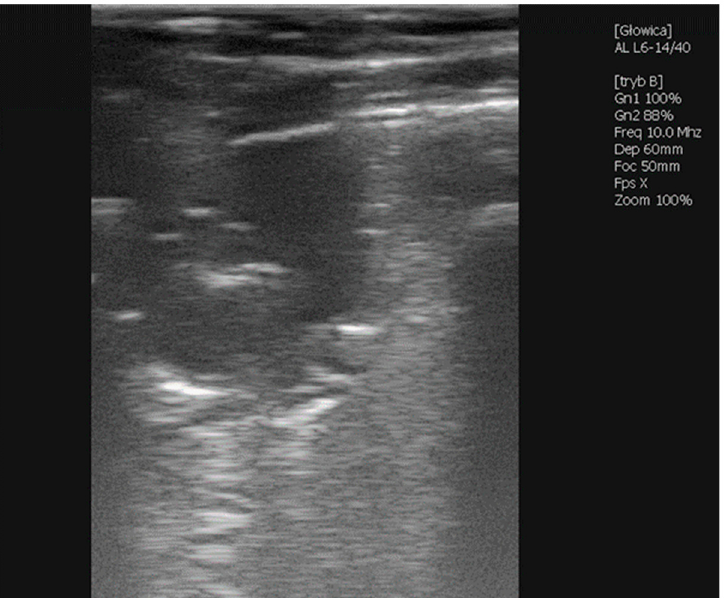
Figure 5. Ultrasonographic picture of a circular abscessation observed in the left lung, 16th ICS during the second examination of Case 3. Visible parts of the abscess are 26.4 mm in depth and 23.3 mm in width.